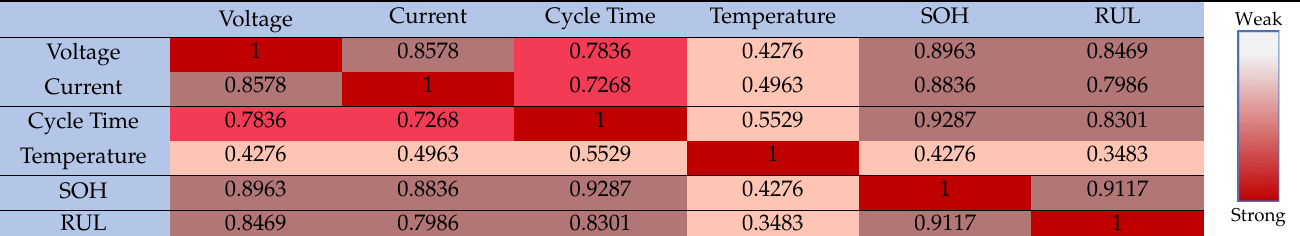
Table 1. The PCCs of the different health indicators.